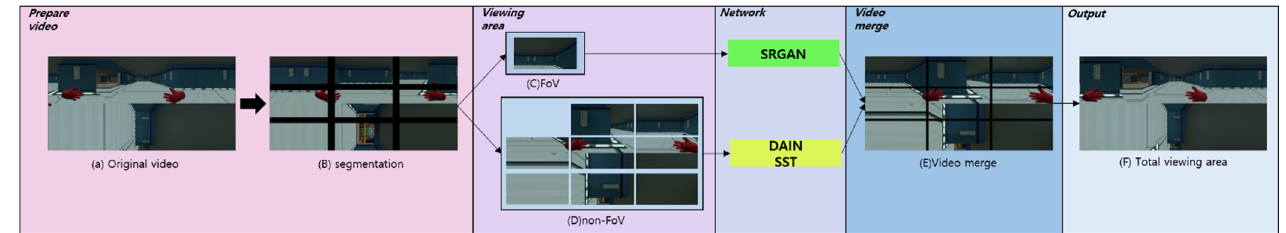
Figure 22. Model processing.